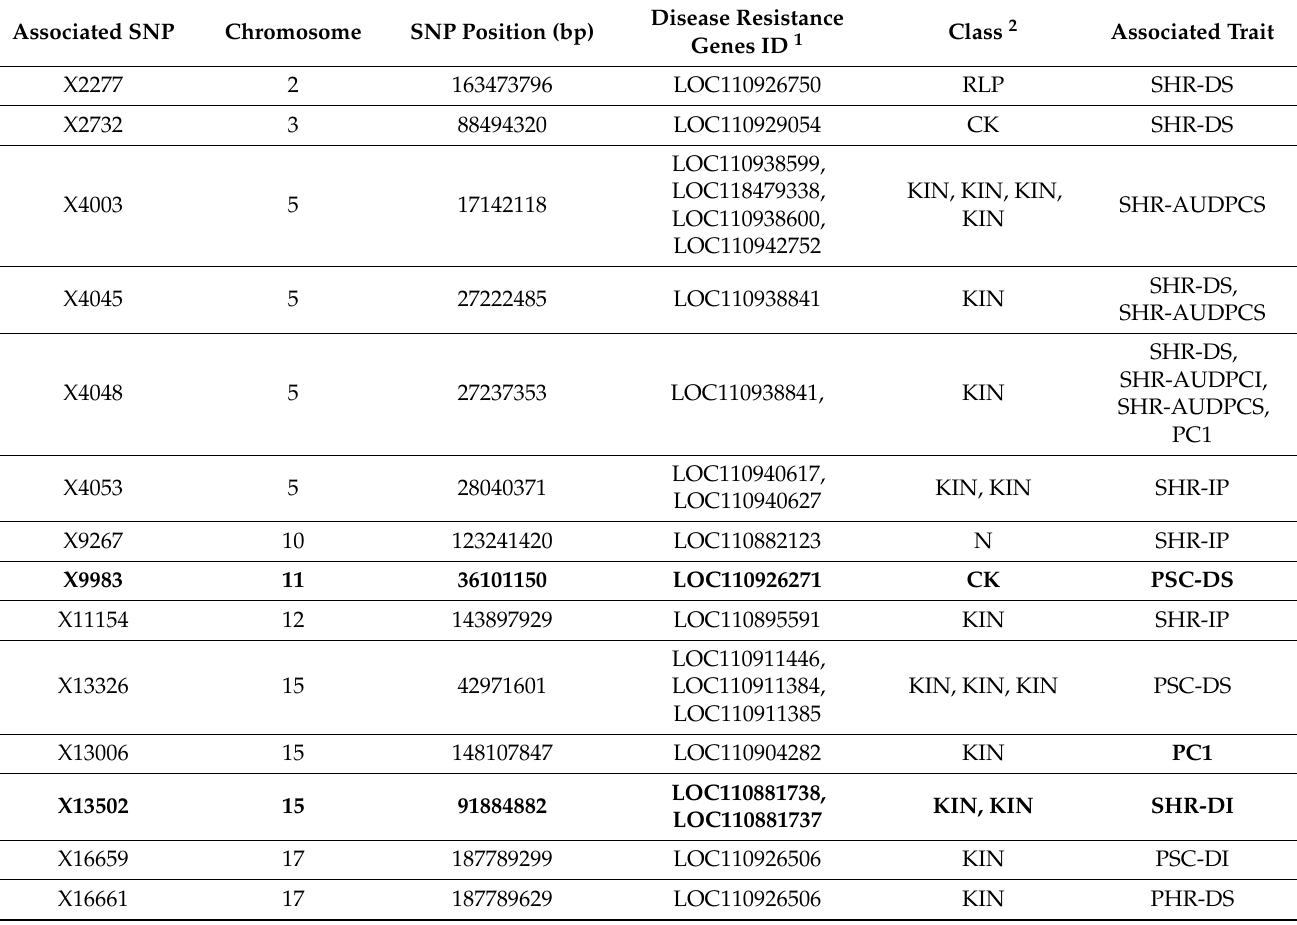
Table 1. Disease resistance candidate genes physically located near associated